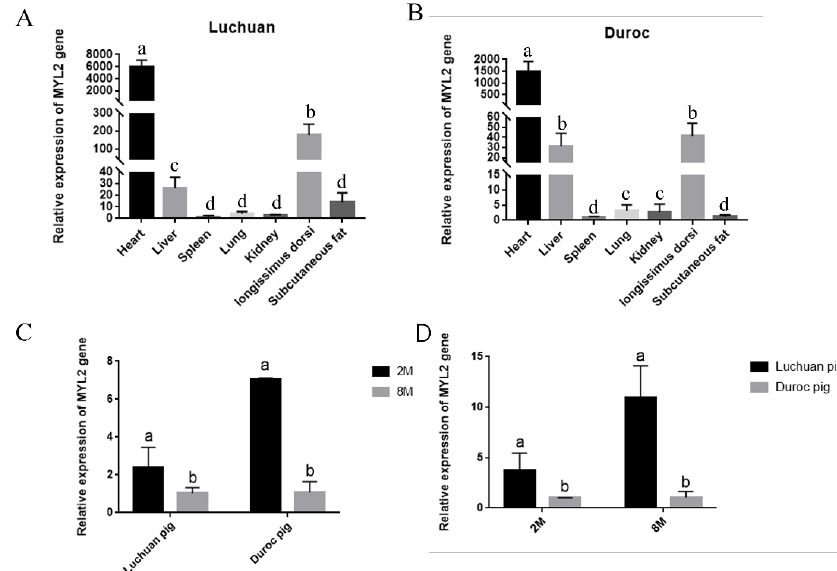
Figure 4. Expression pattern of the MYL2 gene. ( A , B ): MYL2 mRNA expression pattern in different tissues of two-month-old Duroc and Luchuan pigs. ( C , D ): MYL2 mRNA expression pattern in different pig breeds and developmental periods. Different letters indicate a significant difference ( p < 0.05). All the results are expressed as means ±